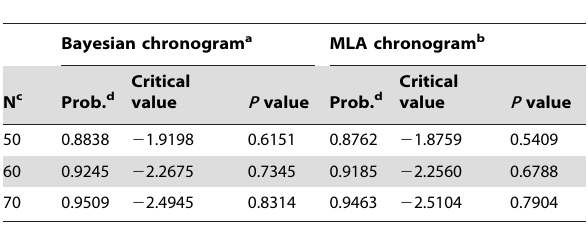
Table 4. Monte Carlo Constant Rates (MCCR)